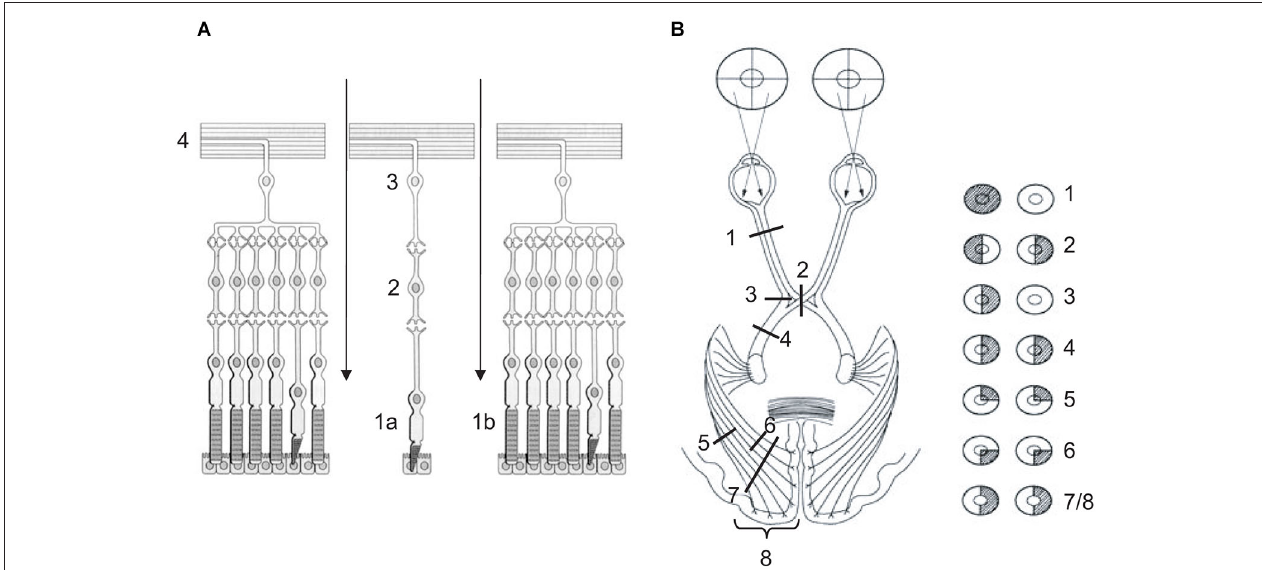
monocular nasal blindness. (4) Unilateral lesion of optic tract, or (7) of both lower and upper optic radiations, or (8) of primary visual cortex causes homonymous hemianopia (HH). (5) Unilateral lesion of lower optic radiations causes homonymous superior quadrantanopia. (6) Unilateral lesion of upper optic radiations causes homonymous inferior quadrantanopia. (A) Adapted from Bear et al. (1997, p. 224, Figure 9.14) (© O.A. Coubard, with permission); (B) Adapted from www.chups.jussieu.fr/ polys /neuro/ semioneuro/ POLY.Chp.3.6.3. html, Figure 8 (© O.A. Coubard, with